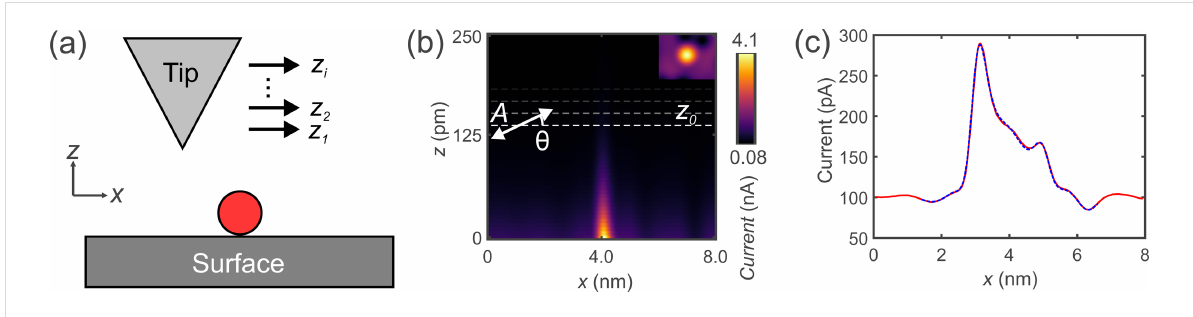
Figure 4: Two-dimensional (2D) current map without oscillation and calculated and recorded curve with oscillation. (a) Sketch of the tip taking a 2D dataset of a surface feature (red circle) at different heights z i . (b) 2D current map of an iron adatom on Cu(111) taken with a metal tip. The dashed white line indicates the current line at z 0 at which the 2D current map is used to calculate the curve with oscillation. The inset shows a constant cur- rent STM image of an iron adatom on Cu(111), which is used for the 2D current map. (c) Line profile of a constant-height scan of an iron adatom on Cu(111) with oscillation shown by the red solid curve. The fit uses the 2D current map yielding an amplitude A = 1050 pm ± 2% and a sensor tilt of θ = 1.59° ± 2% shown by the blue dashed